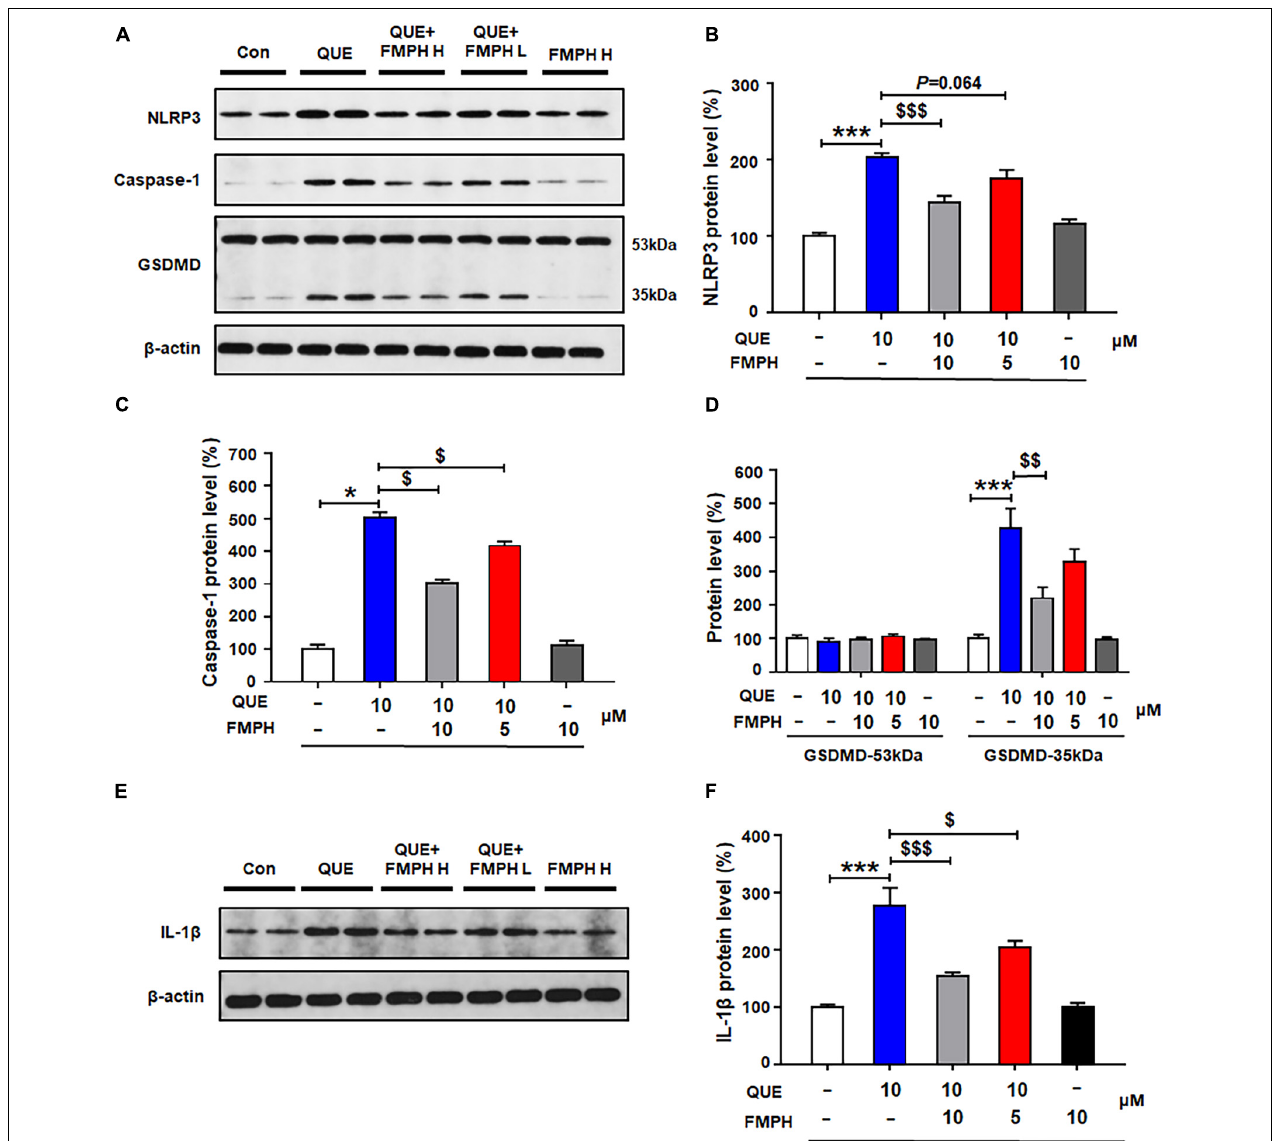
FIGURE 7 | 2-(3-Trifluoromethylphenyl) histamine (FMPH) co-treatment reversed quetiapine induced activation of NLRP3/caspase-1 signaling and inhibited IL-1 β protein expression in cultured astrocytes. (A–F) Cultured cells were treated with vehicle [dimethyl sulfoxide (DMSO) + water], quetiapine 10 µ M, quetiapine10 µ M + FMPH 10 µ M, quetiapine 10 µ M + FMPH 5 µ M, or FMPH 10 µ M for 24 h. Western blot was used to examine the expression of NLRP3, caspase-1 (20 kDa), GSDMD (53 and 35 kDa), and IL-1 β . The data are presented as the mean ± standard error of the mean. * p < 0.05, *** p < 0.001 vs.